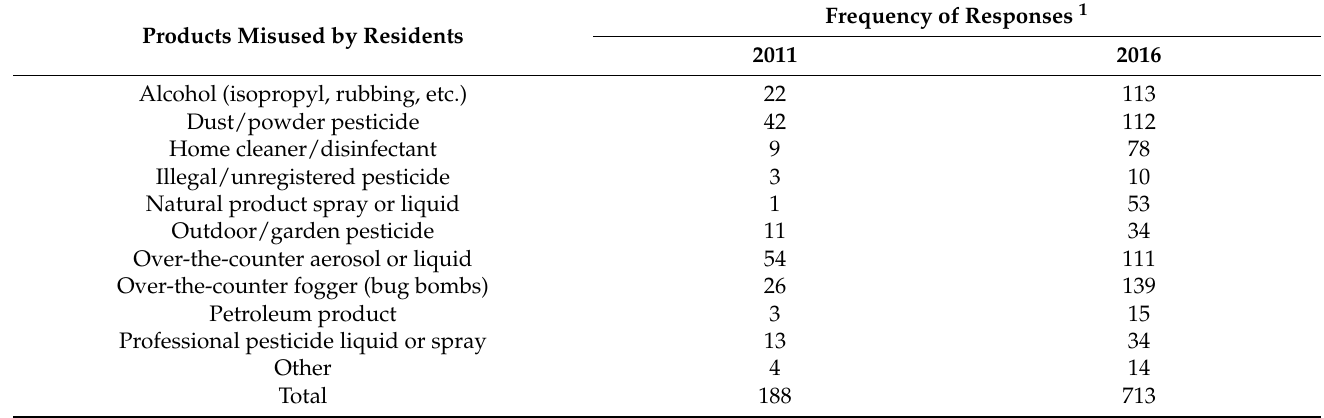
Table 4. Products misused by residents in 2011 and 2016 according to Ohio